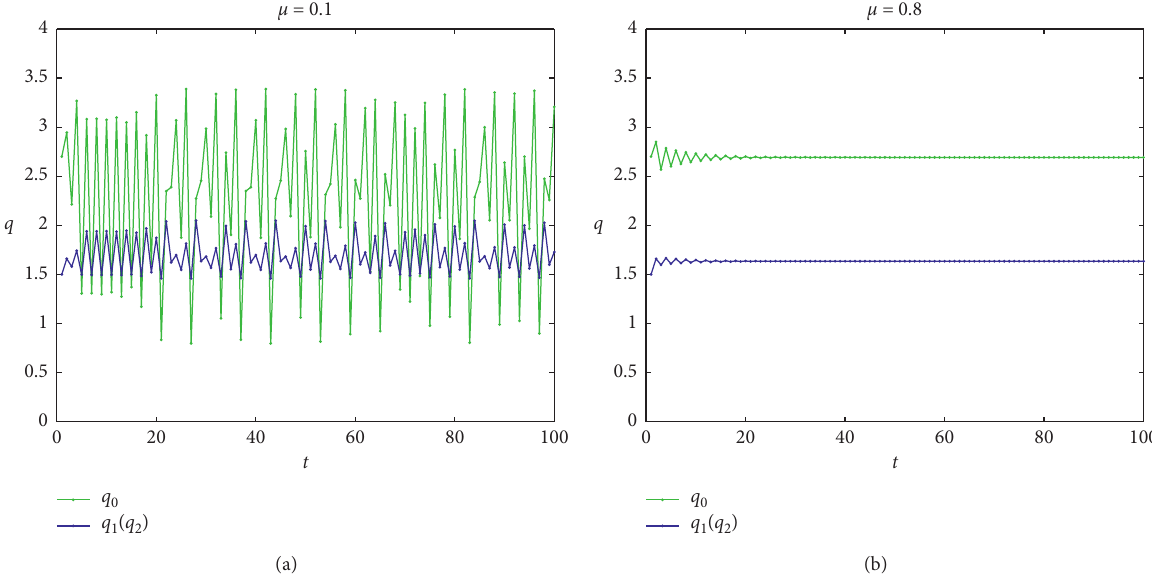
Figure 6: Revolution trajectories for system (26) when μ � 0 . 1 and μ � 0 .